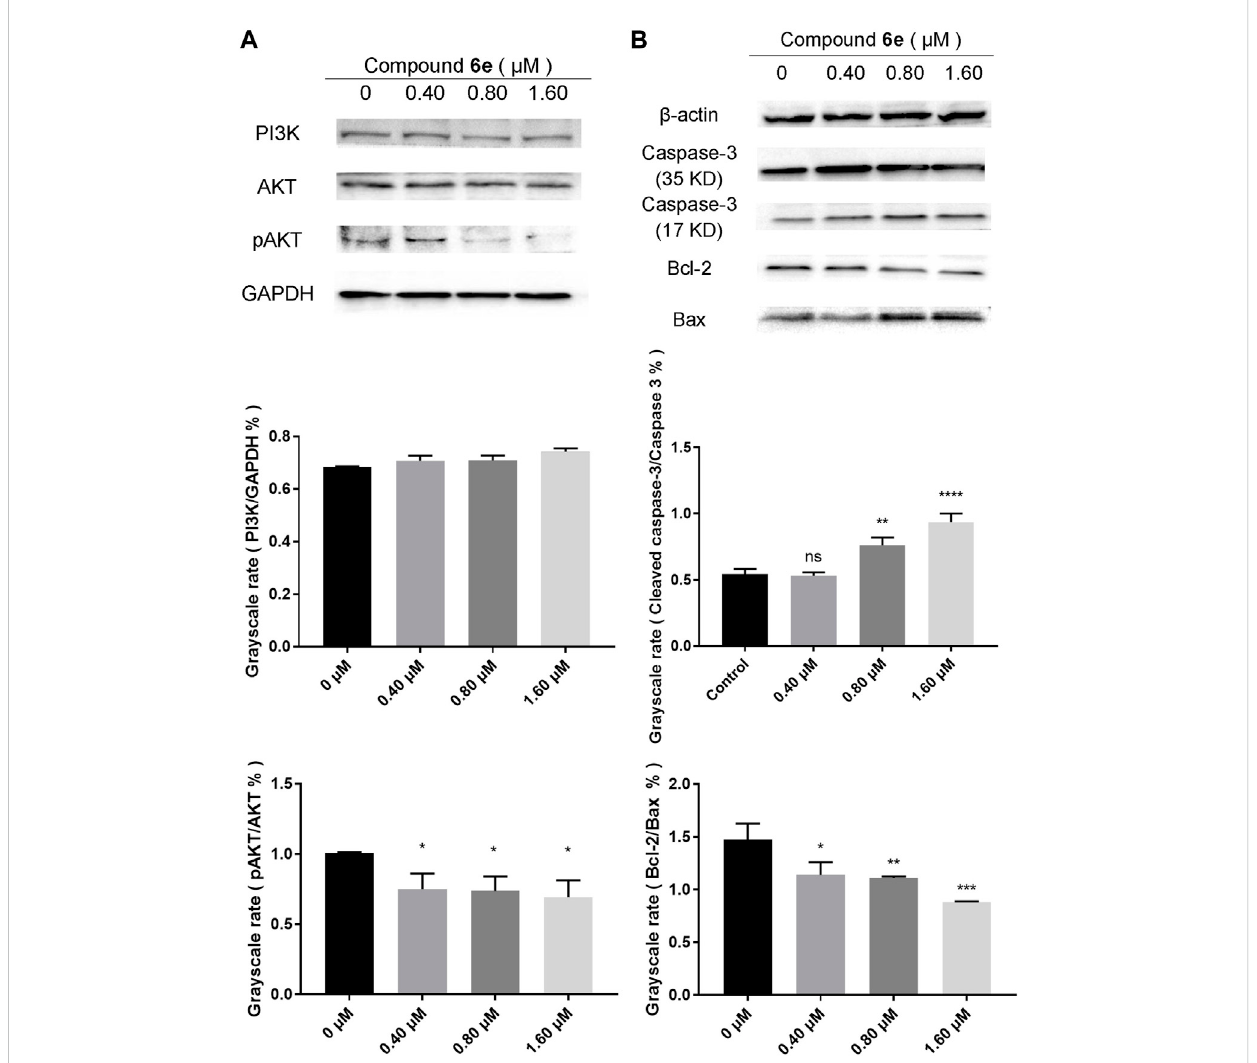
FIGURE 9 WesternblotanalysisofrelatedproteinsofKBcellstreatedwithcompound 6e . (A) TheexpressionlevelsofthePI3K,AKTandpAKTinKBcellstreated with compound 6e . (B) The expression levels of caspase-3 (35 KD, 17 KD), Bcl-2 and Bax in KB cells treated with compound 6e . Quanti fi cation of the protein levels ( n = 3). **** ( p < 0.0001), *** ( p < 0.001), ** ( p < 0.01), * ( p < 0.05), ns (not signi fi cant).